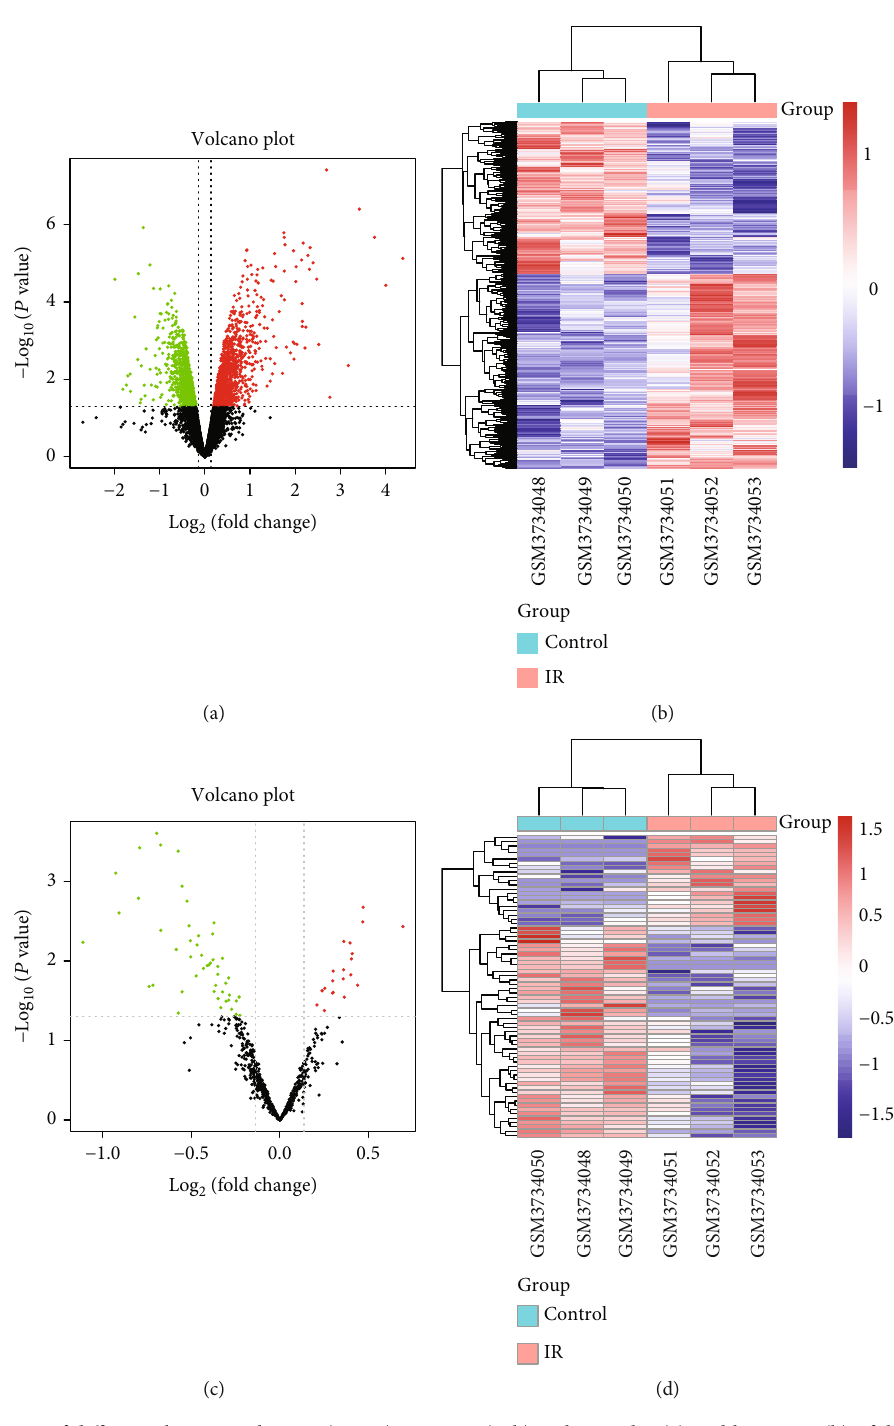
Figure 1: Identi fi cation of di ff erential expressed genes (DEGs) in MI/R. (a, b) Volcano plot (a) and heat map (b) of di ff erential expressed- (DE-) mRNAs between MI/R and normal group in dataset GSE130217. (c, d) Volcano plot (c) and heat map (d) of DE-lncRNAs between MI/R group and normal group in dataset